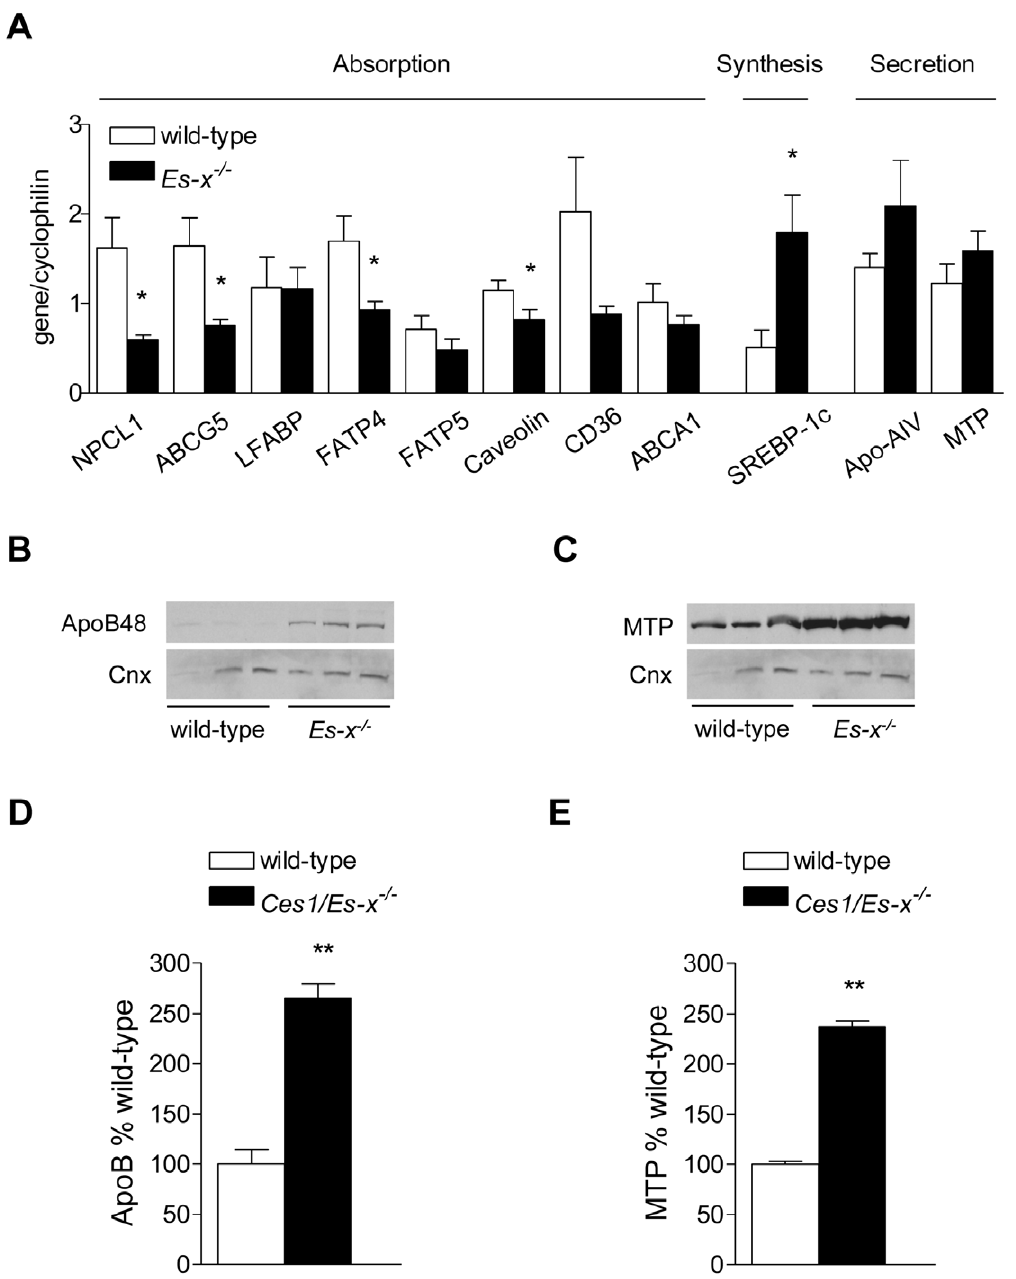
Figure 6. Decreased expression of lipid absorption and increased expression of lipid secretion markers in Ces1/Es-x 2 / 2 mice. (A) Intestinal expression of lipid absorption, synthesis and secretion genes in intestines from 24-week old mice was analyzed by qPCR. Mice were fasted for 4 h. N=5 mice/group. *p , 0.05 vs. wild-types. (B) Immunoblot of intestinal ApoB48. (D) Immunoblot of intestinal MTP. Same animals as in (A) were used. Cnx, calnexin = loading control. (D) and (E) quantitation of the immunoreactive ApoB48 and MTP bands, respectively. **p , 0.01 vs. wild- type.